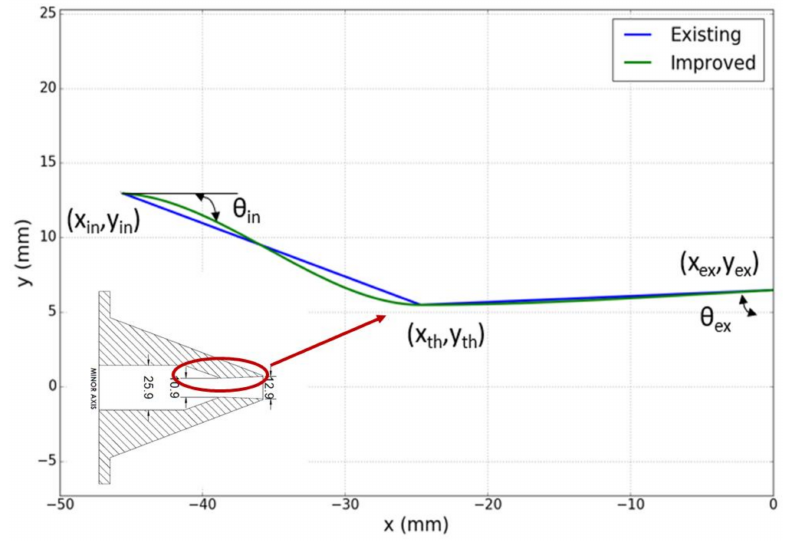
Figure 4. Improved nozzle design with contoured walls shown in